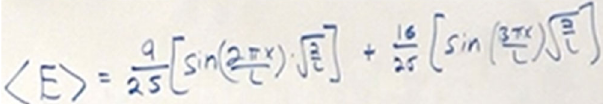
FIG. 5. Wayne ’ s externalization of eigenstates in place of eigenvalues for the summation